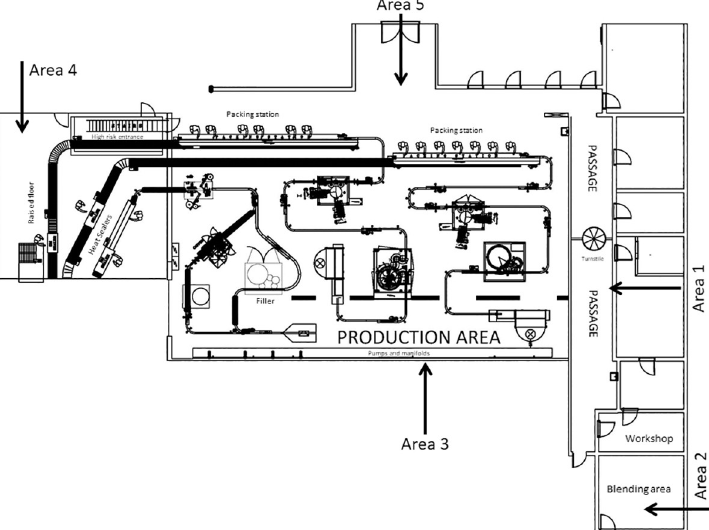
Fig 1. Schematic layout of the fruit juice manufacturing facility. Different sampling areas: Area 1 (entrance to the production area), Area 2 (preparation and mixing of materials), Area 3 (between the production lines), Area 4 (dispersion of bottles) and Area 5 (filling of bottles with the final product).